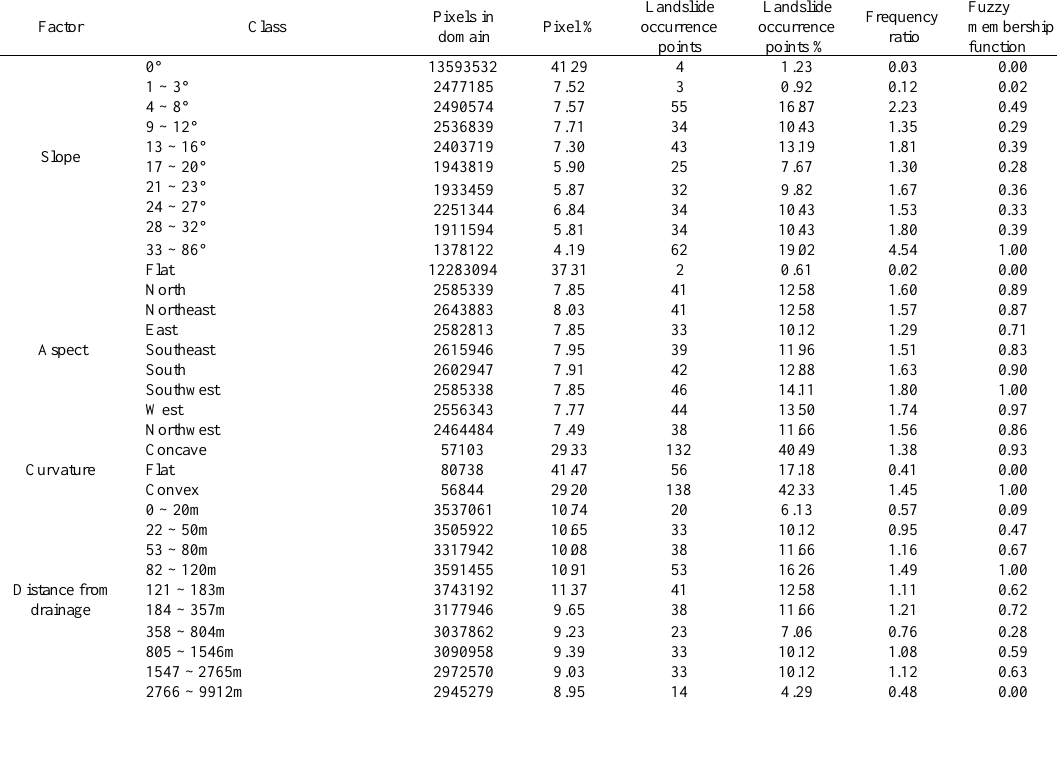
Table 2. Spatial relationships between each factor and landslide and fuzzy membership values Factor Class